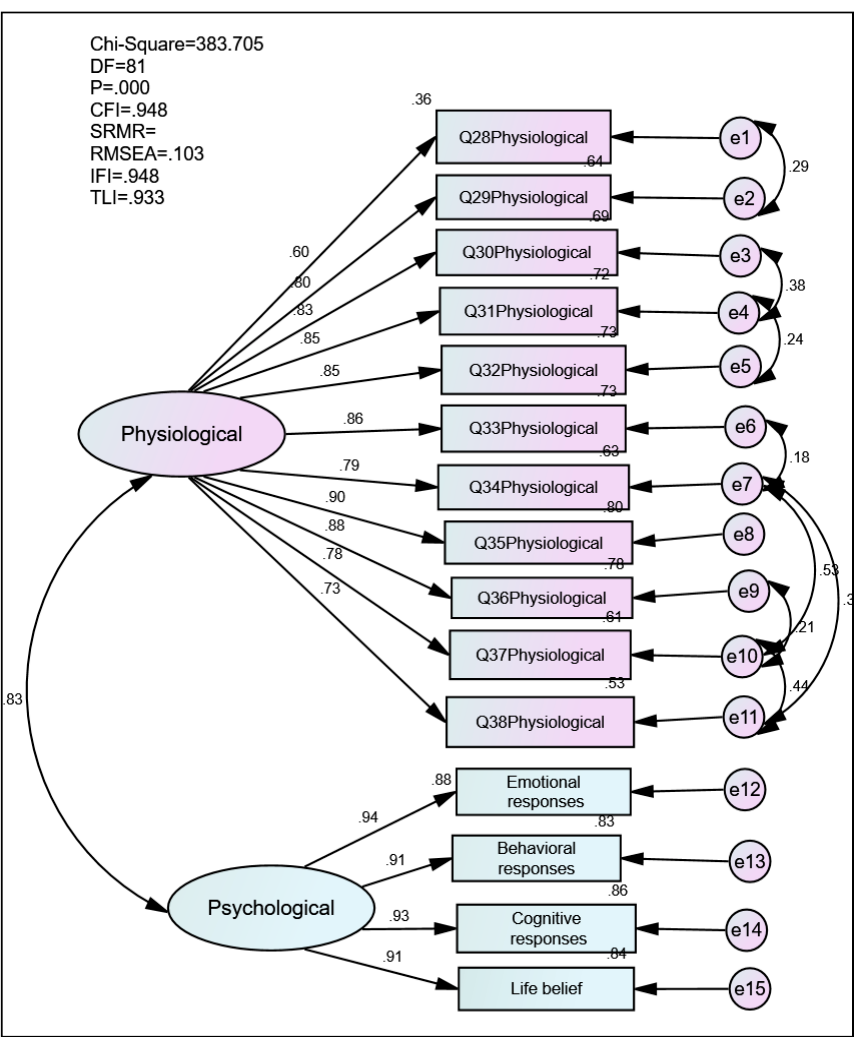
Figure 4. Measurement model. Table 5. Index level for the initial model.